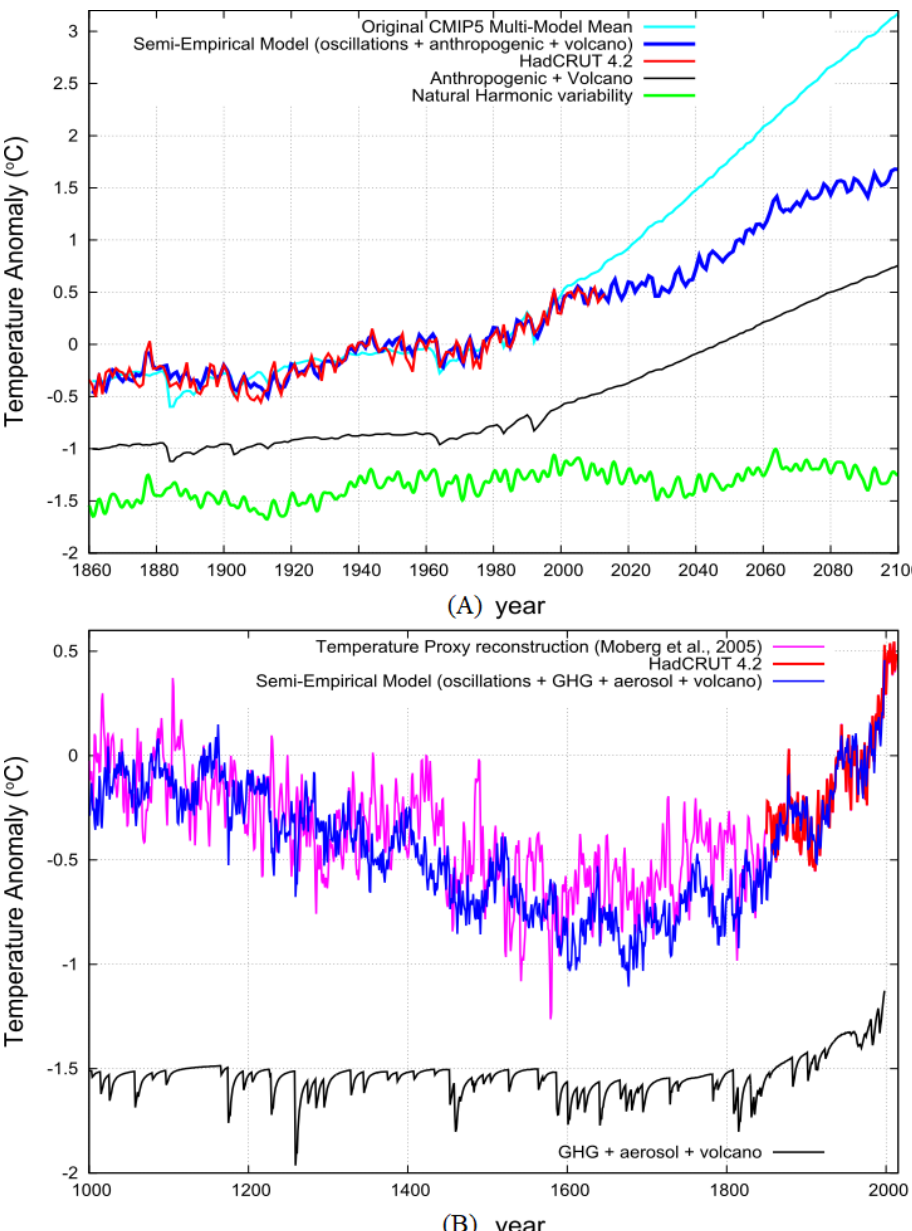
Figure 14. Astronomically optimized semi-empirical model (blue) uses the parameters listed in Table 3 using frequency and phases of the decadal to millennial harmonics deduced from astronomical considerations against a proxy temperature record (violet) and the instrumental temperature record (red). ( A ) The anthropogenic plus volcano signature (black); the harmonic natural variability of the global surface temperature (green). The two curves are combined to obtain the blue curve. The rmsr is about 0.07 ◦ C. ( B ) The GHG+Aerosol+Volcano signature (includes the anthropogenic signature since 1850) with λ = 1.5 ◦ C